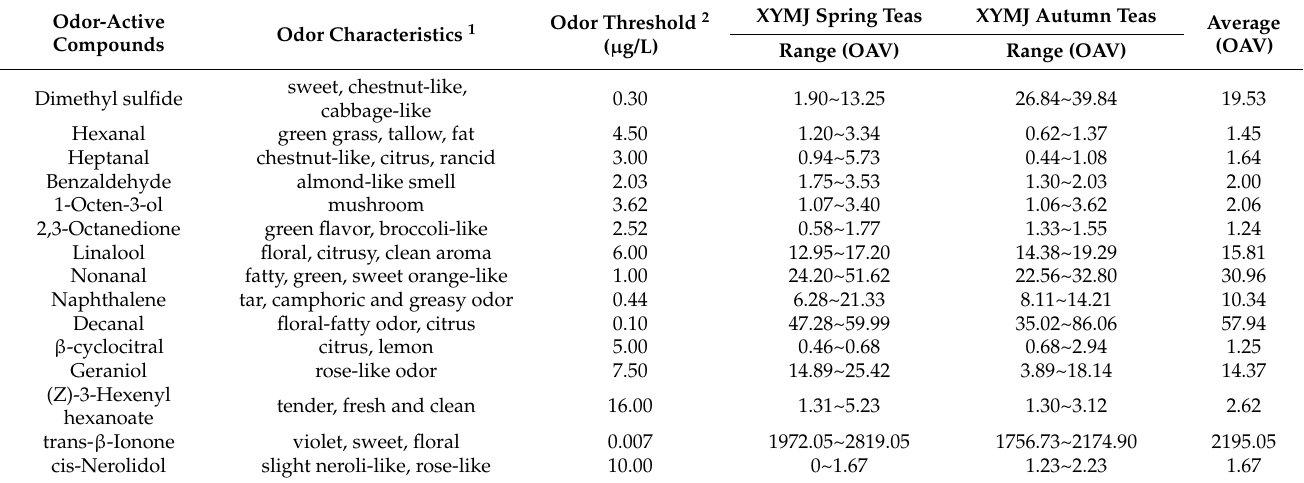
Table 3. The key odorants responsible for the XYMJ green tea aroma (OAV >